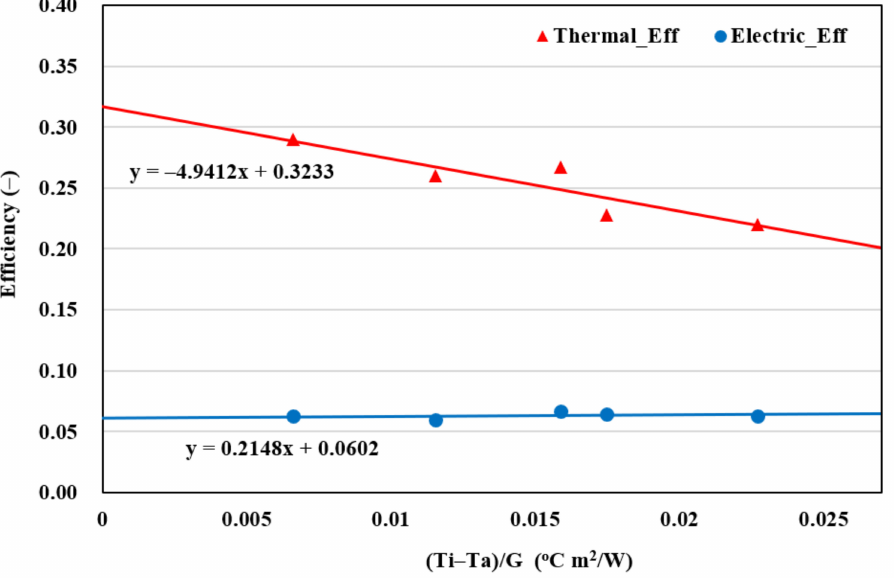
Figure 7. Thermal and electrical efficiencies of air-type PVT collector based on simulation